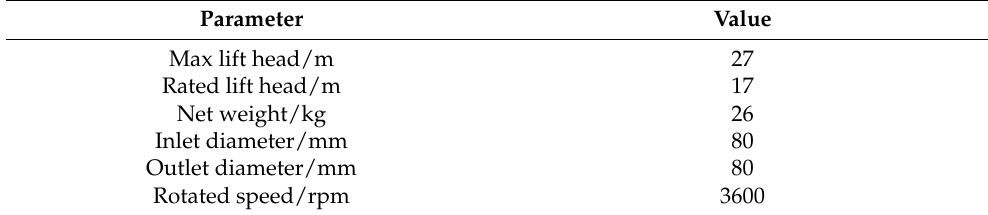
Table 5. Centrifugal pump parameters.